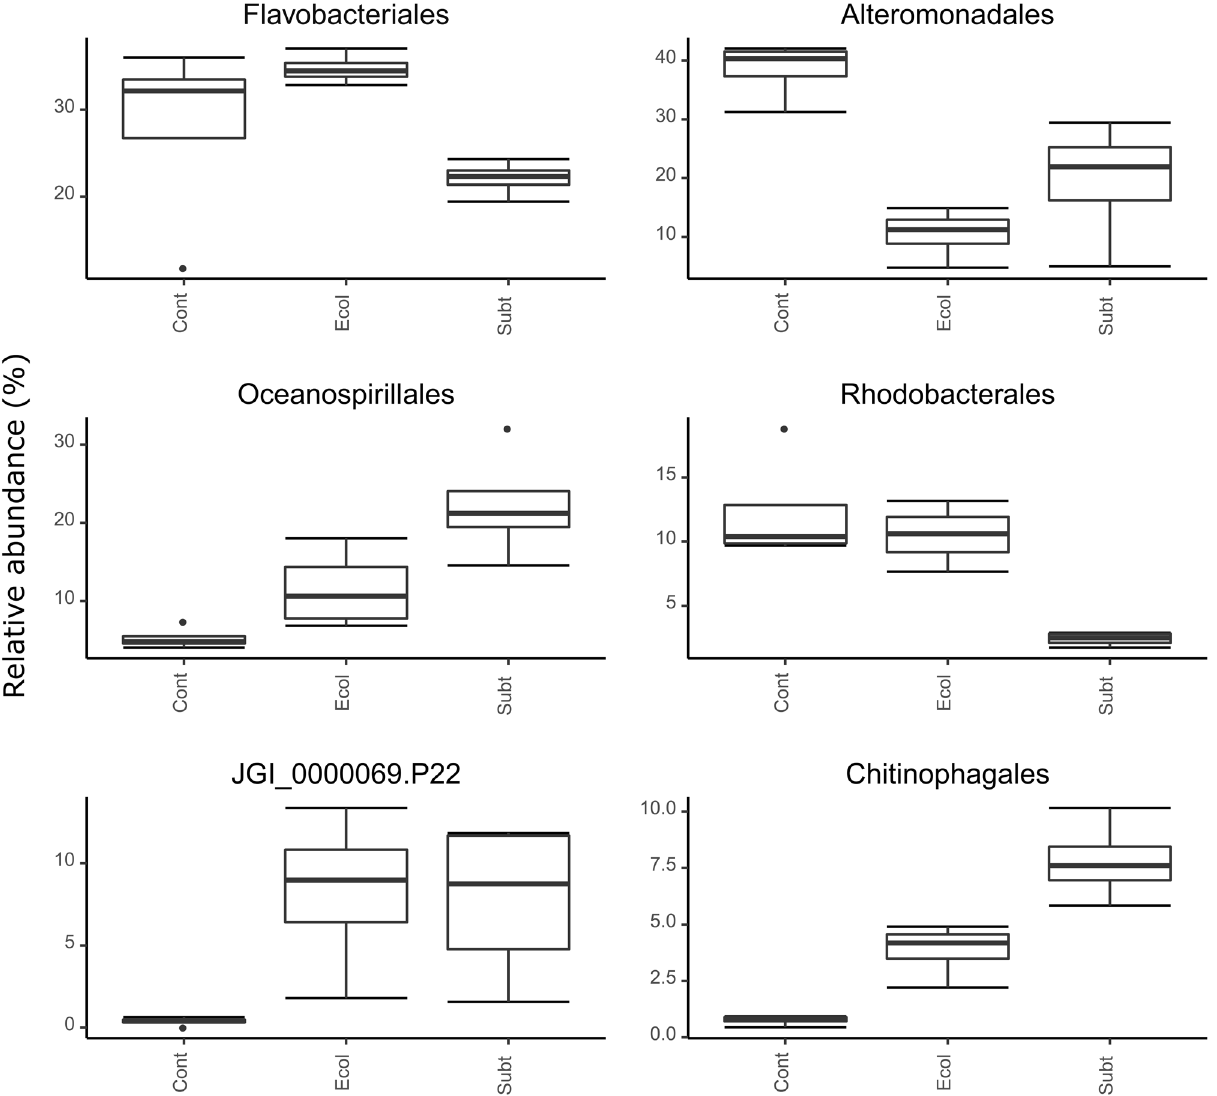
Figure 5. Relative abundances of the six most abundant prokaryotic orders. Results of GLM-ANOVA anaylsis: Flavobacteriales: F 2,9 = 4.69, P = 0.04, Alteromonadales: F 2,9 = 6.12, P = 0.021, Oceanospirillales: F 2,9 = 11.76, P = 0.003, Rhodobacterales: F 2,9 = 8.64, P = 0.008, JGI_0000069.P22: F 2,9 = 16.77, P < 0.001, Chitinophagales: F 2,9 = 65.73, P < 0.001. The groups sampled were: Cont: Control; Ecol : E. coli DH5α; Subt: P. rubra